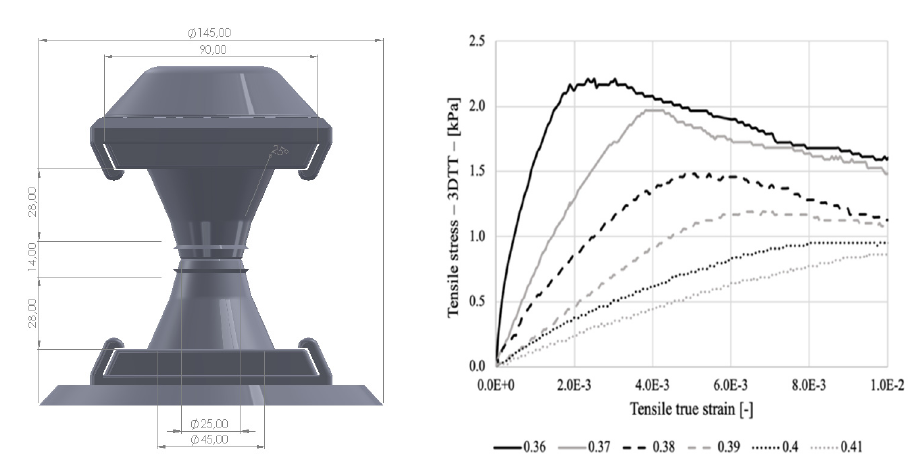
Figure 6. a) Diagram of the 3DTT and b) an example of stress vs. strain curves obtained from data analysis of the test.